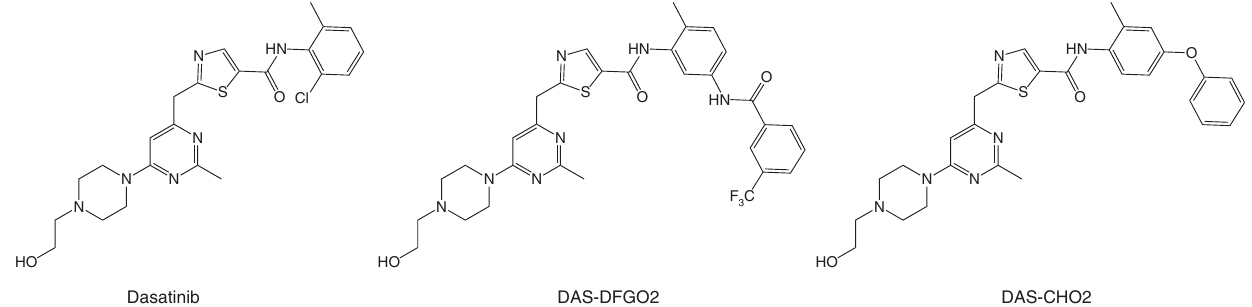
Fig. 2 Chemical structure of dasatinib, DAS-DFGO2 and DAS-CHO2. The ligands feature a common dasatinib scaffold with substituents at the phenyl moiety 30